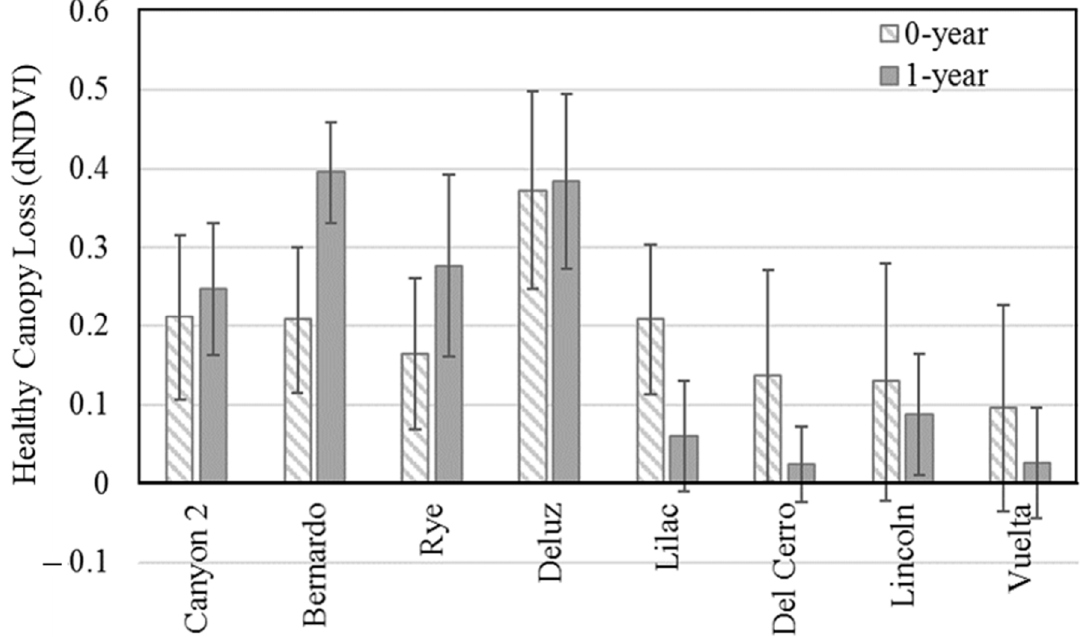
图 5 Figure 5. The comparison of green canopy loss (dNDVI) within the invasive class at 0-year and 1-year post-fire for each